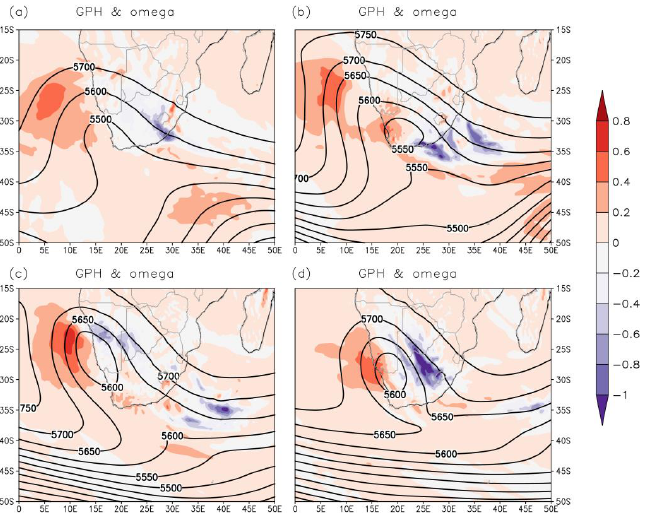
Figure 6. Geopotential height (m) and omega (Pa/m) 500 hPa during ( a ) 14, ( b ) 15, ( c ) 16, ( d ) 17 August 2002.